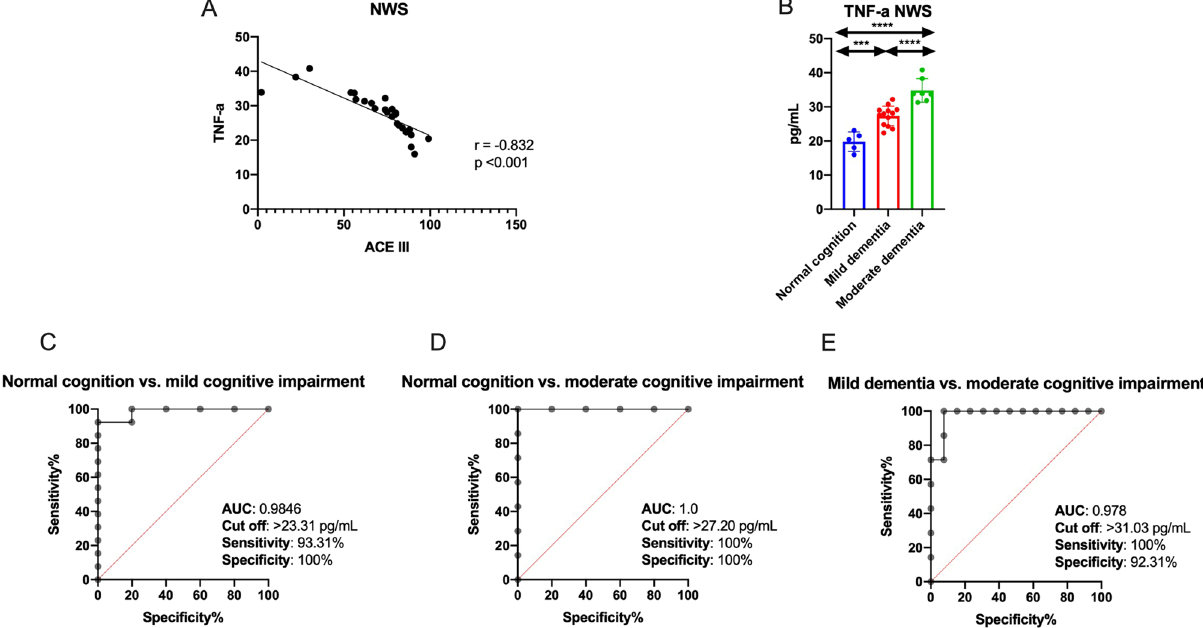
Figure 1. Diagnostic significance of salivary TNF-α in ischemic stroke patients: correlation between salivary TNF-α and cognitive function in ACE III scale ( A ), results of ROC analysis for salivary TNF-α in relation to cognitive function status in ACE III scale ( B – E ). Differences statistically significant at: **p < 0.005, ****p <